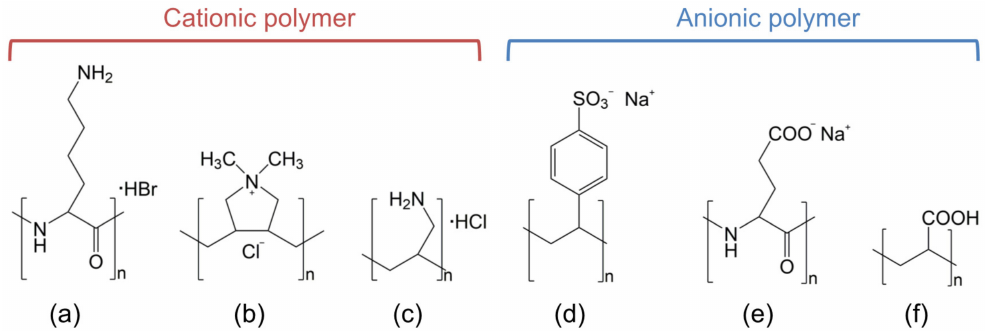
Figure 1. Schematic representation of the cationic polymers and anionic polymers used: poly- L -lysine hydrobromide ( a ), poly(diallyldimethylammonium chloride) ( b ), poly(allylamine hydrochloride) ( c ), poly(sodium 4-styrenesulfonate) ( d ), poly- L -glutamic acid sodium ( e ), and poly(acrylic acid) ( f ).